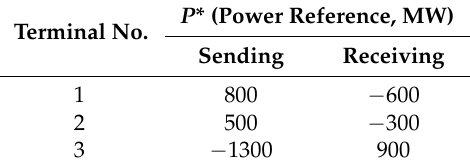
Table 3. Parameters of simulated system.